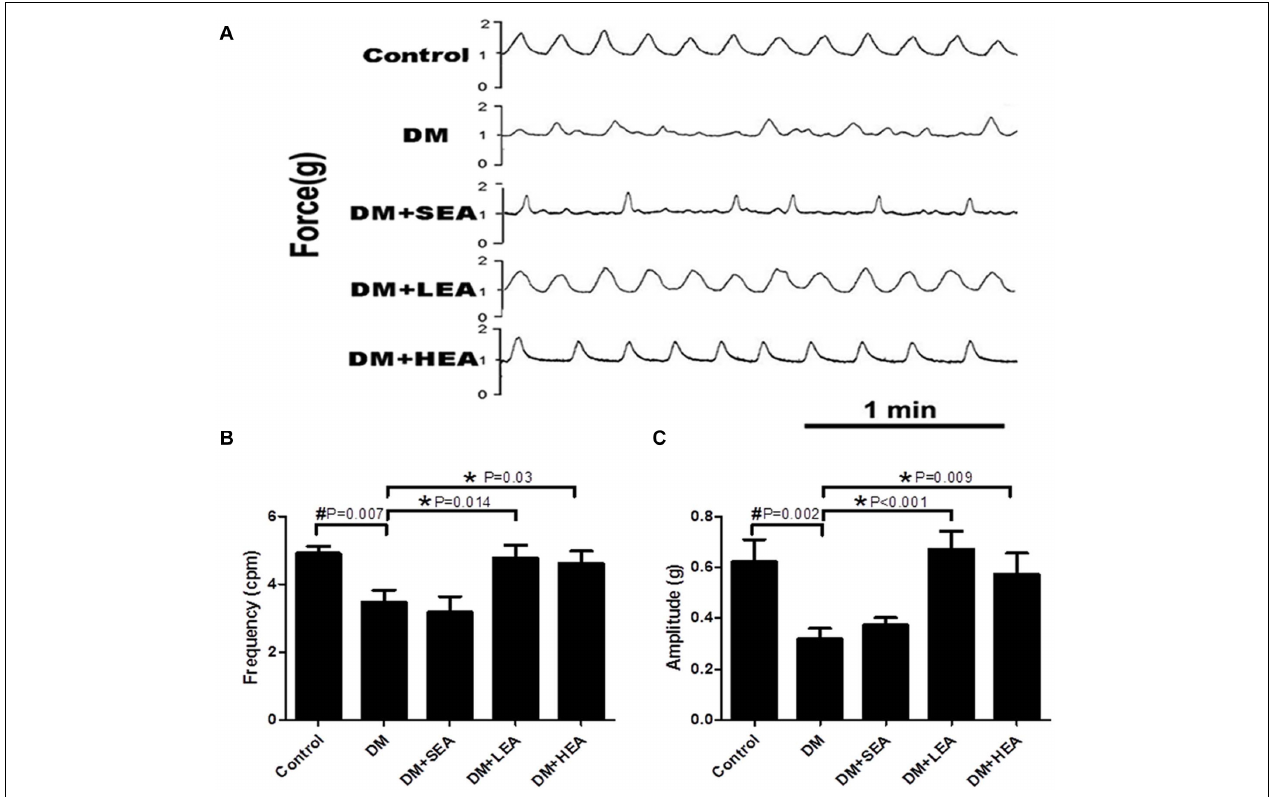
FIGURE 2 | Spontaneous contraction of gastric circular muscle strips in different groups. (A) The representative traces of spontaneous contraction wave of the gastric antrum smooth muscle strips in each group. (B) The frequency of spontaneous contraction wave in each group, and (C) reveals the amplitude of spontaneous contraction wave in each group. One-way ANOVA was used to analyze the data, and the Dunnett T3 post hoc test was used for the analyses of the body weight (4 and 6 weeks), with the LSD post hoc test for the analyses of the body weight (0, 2, and 8 weeks) and the blood glucose. * P < 0.05 compared with the DM group, # P < 0.05 compared with the control